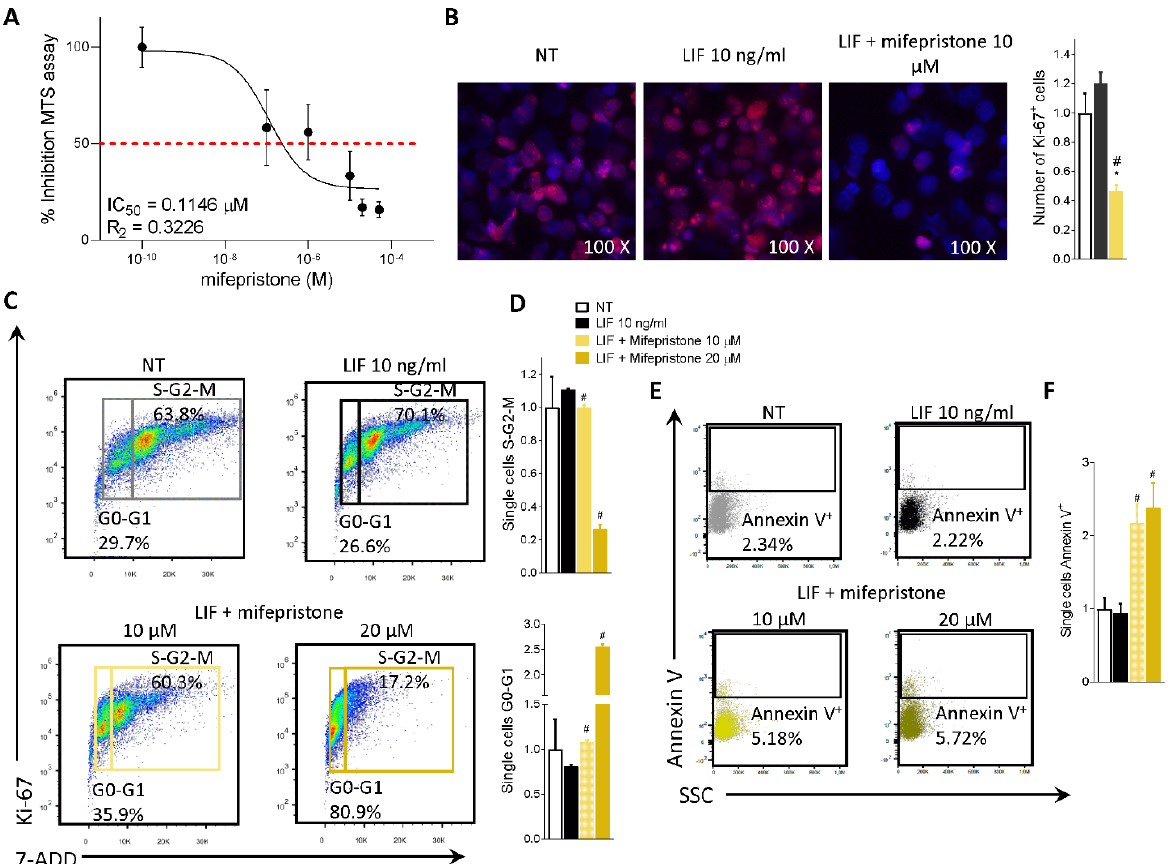
Figure 6. Mifepristone reduces MIA PaCa-2 cell proliferation and reverts EMT process. ( A ) Dose- response curve of mifepristone (0.1, 1, 10, 20, 50 µ M) was determined using MTS assay on MIA PaCa-2 cells (n = 10). ( B ) Immunofluorescence analysis of Ki-67 positive MIA PaCa-2 cells left untreated or challenged with LIF (10 ng/mL) alone or in combination with mifepristone 10 µ M; and estimated number of Ki-67 positive cells. MIA PaCa-2 cells were serum-starved and challenged with a vehicle or LIF 10 ng/mL alone or in combination with mifepristone (10, 20 µM) for 24 h. Cell cycle phase analysis was performed by Ki-67/7-AAD staining through IC-FACS. ( C ) Representative IC-FACS shows cell cycle fraction in each experimental group. ( D ) Data shown are frequencies of cells in the G0-G1 phase and S-G2-M phase. ( E ) Representative IC-FACS shows cell cycle fraction in each experimental group. ( F ) Data shown are frequencies of Annexin V + single cells. Each value is normalized to untreated cells, expressed relative to those of controls, which are arbitrarily set to 1. Results are the mean ± SEM of three samples for group (* represents statistical significance versus NT, and # versus LIF, p <